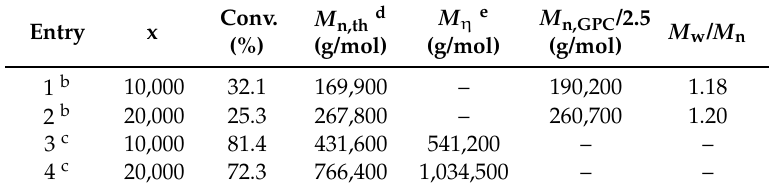
Table 4. Synthesis of high molecular weight PAN under high and ambient pressure a . Conv. Entry x